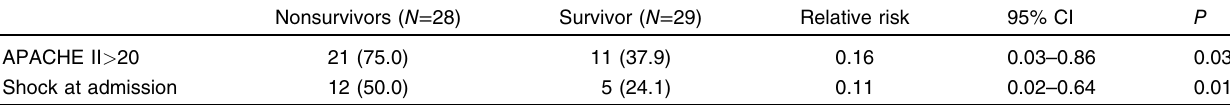
Table 5 Multivariate analysis for in-ICU mortality among patients with severe CAP